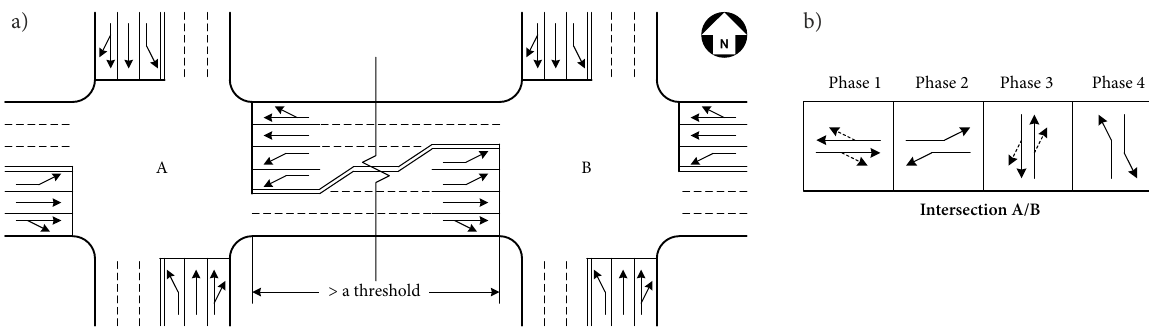
Figure 2. Case 2 of paired four-leg intersections: a – geometry design; b – signal